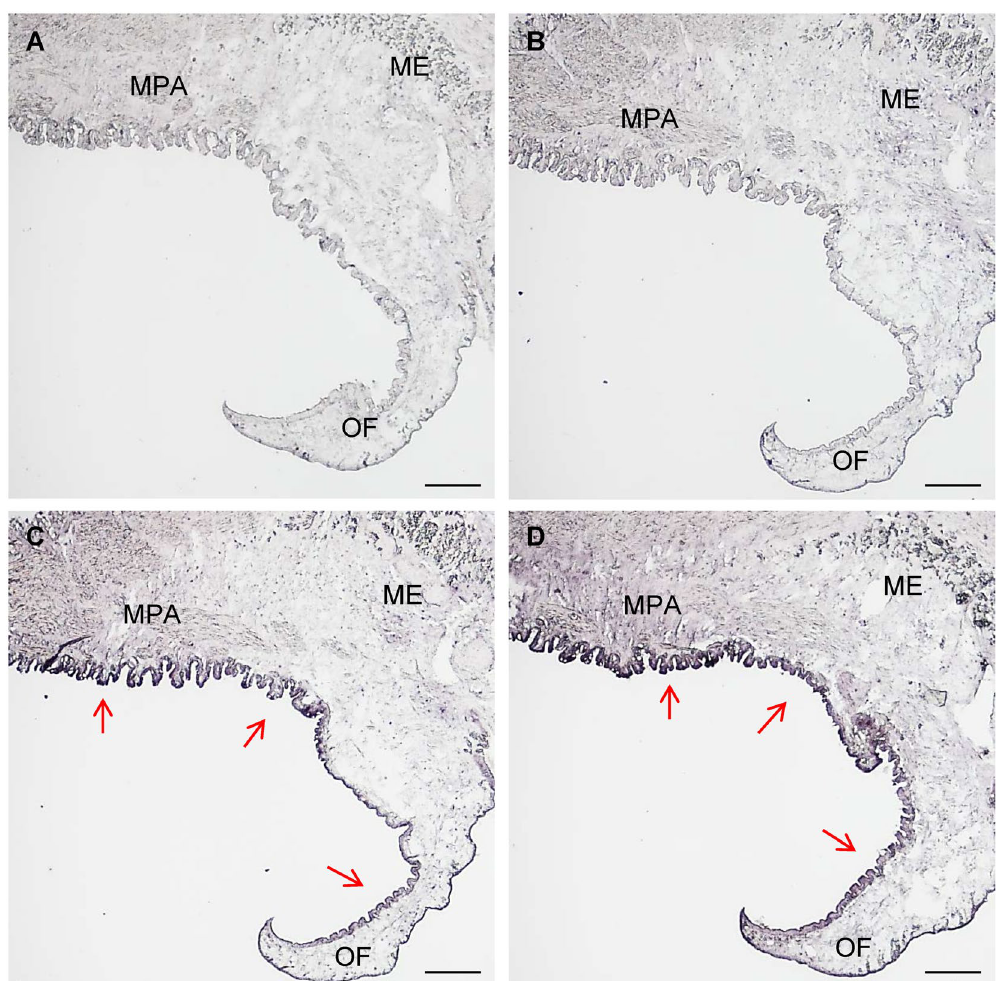
Figure 5. The localizations of PfBMPR1B and PfBAMBI in the mantle of Pinctada fucata detected by in situ hybridization. The sense probes for PfBMPR1B ( A ) and PfBAMBI ( B ) are used as controls. MPA: Mantle pallial. ME: Mantle edge. OF: Outer fold. The red arrows indicate the positive signals (dark blue) detected in the outer epithelia of the MPA and OF using antisense probes of PfBMPR1B ( C ) and PfBAMBI ( D ). Bar = 200 μ